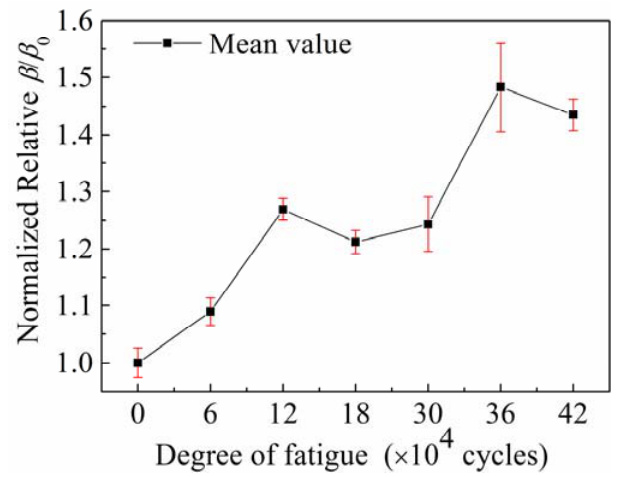
Figure 12. Relationship between the normalized relative β / β 0 of the fatigue specimens and degree of fatigue.